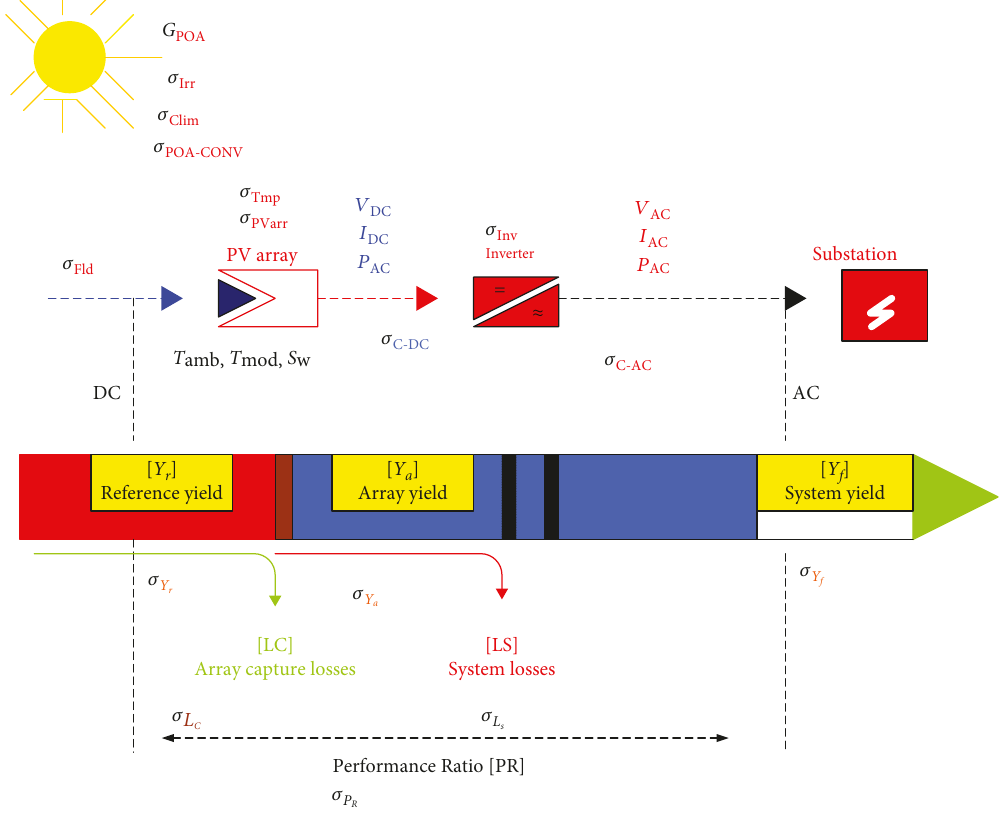
Figure 2: Energy yield fl ow in PV modeling chain parameters are subjected to